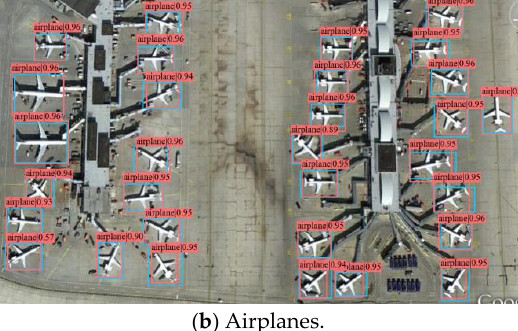
Table 1. Comparison results of the proposed methods and baseline methods on the NWPU VHR- 10 data set.